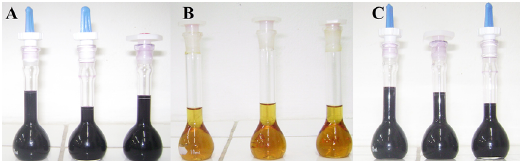
Figure 1. Results obtained for: a) DPPH solution; b) DPPH+BHT and c) DPPH +OCG